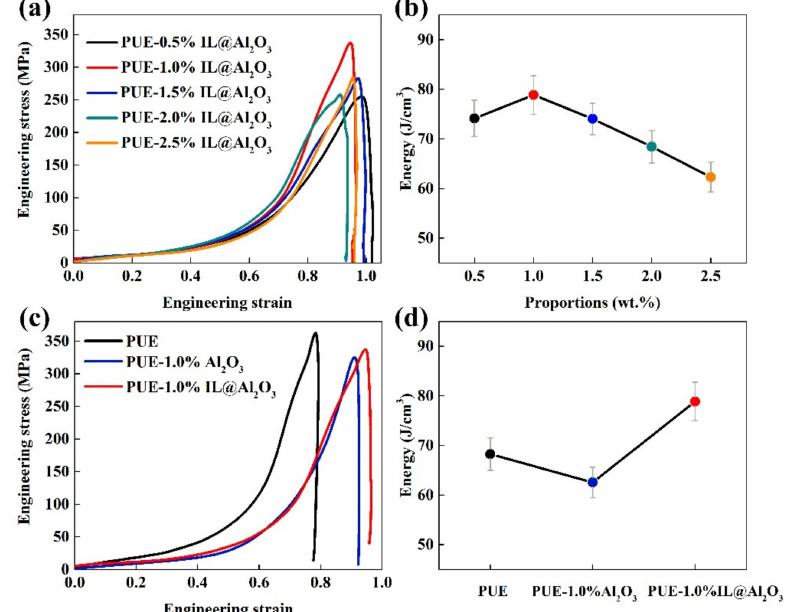
Figure 6. Dynamic impact: ( a ) ER–ES curves and ( b ) energy absorption curves of PUE with different proportions of IL@Al 2 O 3 from 0.5% to 2.5% at the impact force of 0.2 MPa; ( c ) ER–ES curves and ( d ) energy absorption curves of different components (PUE, PUE-1%Al 2 O 3 , PUE-1%IL@Al 2 O 3 ) at the impact force of 0.2